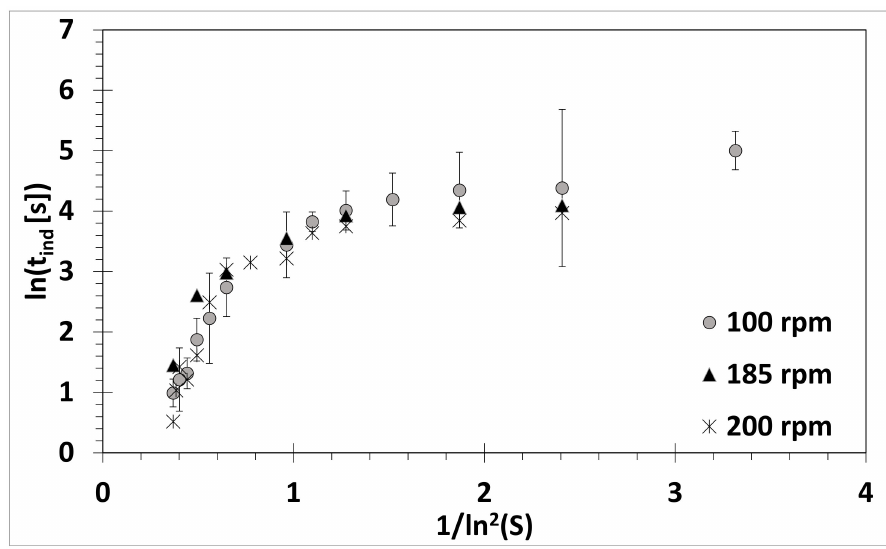
Figure 4. ln( t ind ) in the absence of ultrasound plotted as a function of 1/ln 2 ( S ) for different stirring